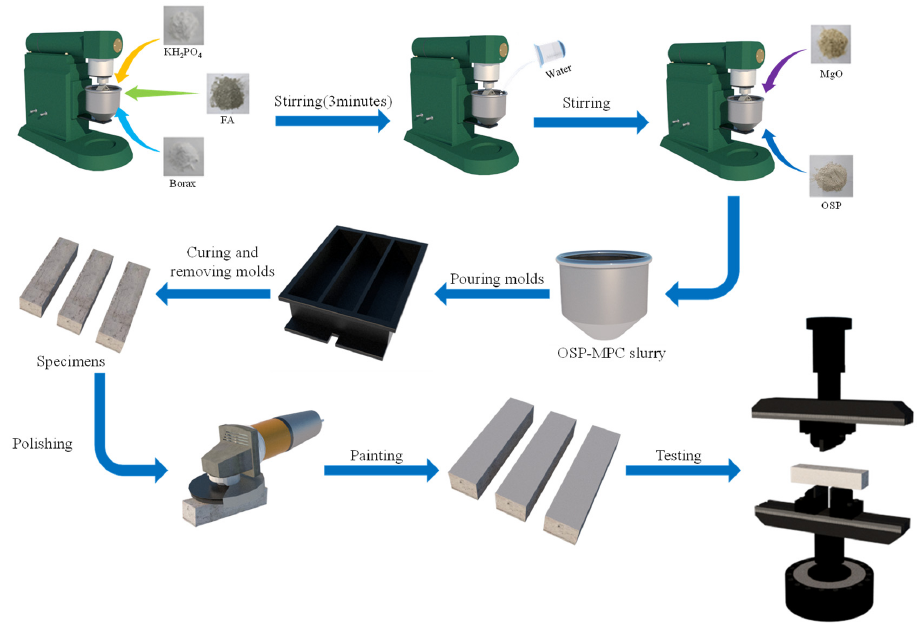
Figure 2. Specimen